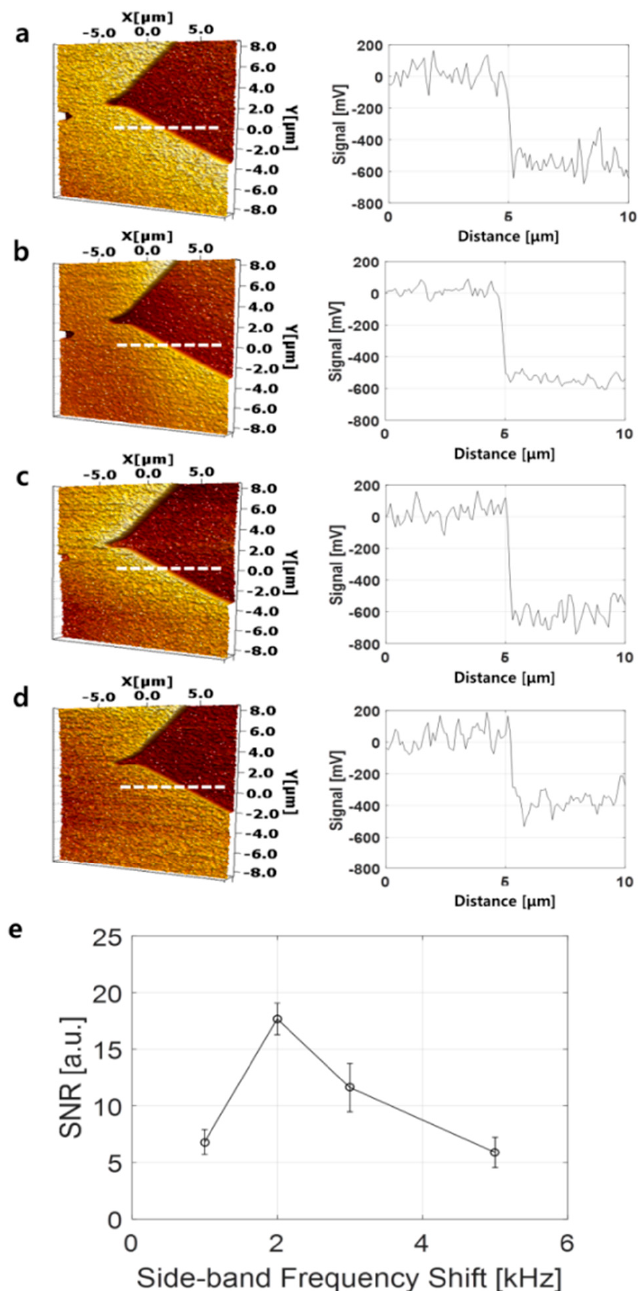
Figure 2. EFM images of the triglycine sulfate (TGS) surface with a scan size of 17 μ m × 17 μ m, showing spontaneous polarization: ( a ) 1 kHz, ( b ) 2 kHz, ( c ) 3 kHz, and ( d ) 5 kHz side-band frequency shift images using the DDS method and plots of the dashed line. ( e ) Signal-to-noise ratio (SNR) graph with different side-band frequencies.